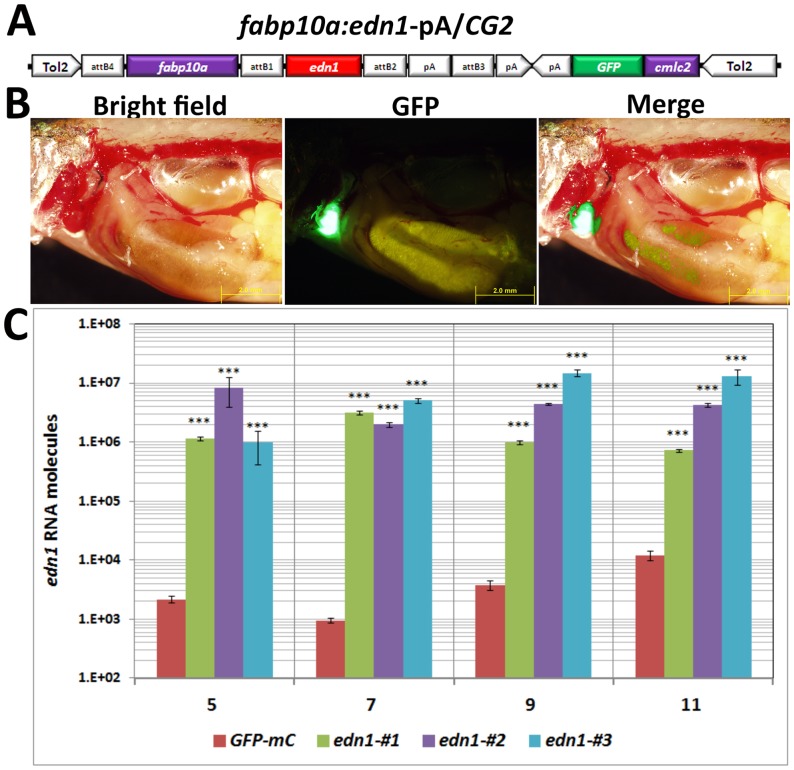
Generation and characterization of edn1 transgenic fish.(A) Diagram of the fabp10a:edn1-pA/CG2 construct that contains Tol2 sequences and the cmlc2:GFP expression cassette. (B) The Edn1 protein was expressed in the liver of the wild-type fish carrying the fabp10a:edn1-pA/CG2 transgene, as indicated by the expression of cmlc2:GFP in the heart (green fluorescence, 200X). Scale bars: 2 mm. (C) Quantitative RT-PCR analysis of edn1 mRNA expression in hepatocytes from 3-, 5-, 7-, 9- and 11-month-old edn1 transgenic fish (n = 3) and control fabp10a:GFP-mCherry transgenic fish. For qPCR analysis, a series of known PCR fragment (GFP) of known concentrations were used as the standard. The edn1 RNA concentration was calculated base on the standard curve. The differences between the edn1 transgenic fish and control fish were assessed using a two-tailed Student's t-test. Asterisks *** represent the P value is less than 0.001.